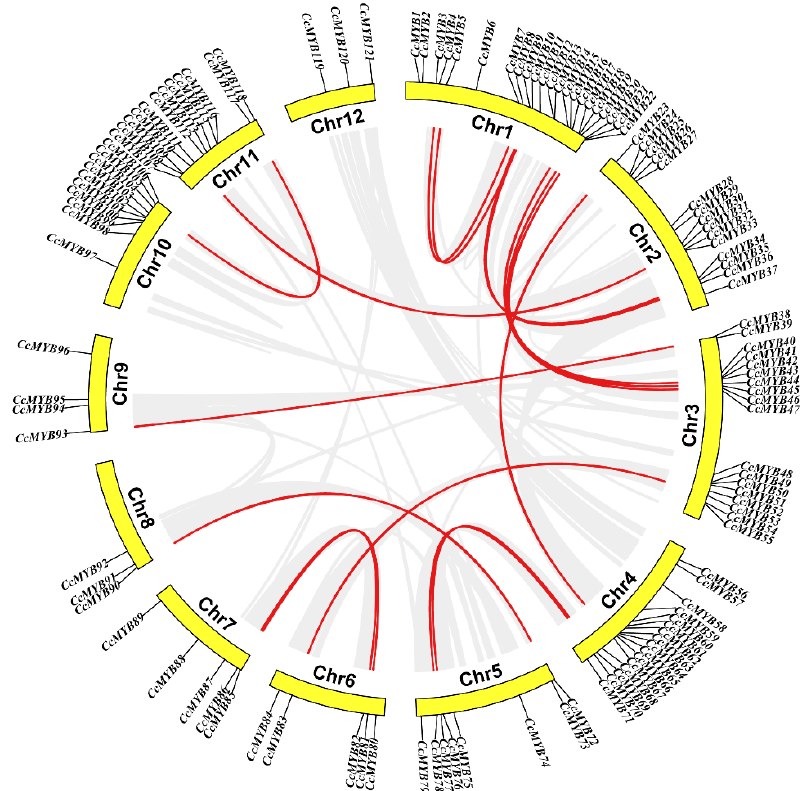
Figure 5. Chromosomal localization and intraspecific collinearity of CcMYBs . The location of the CcMYB gene in the camphor genome was marked on the chromosome. The middle red line represents the duplicated gene pairs for CcMYBs , the gray line represents the genomic duplicated gene pair, and Chr represents the chromosome.